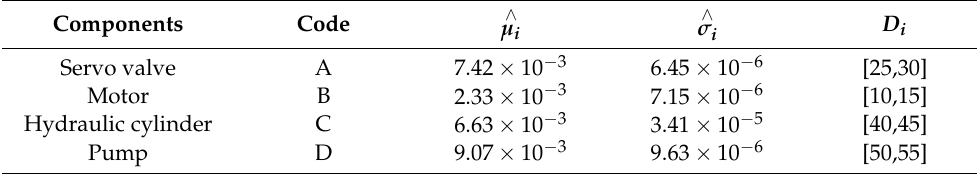
Table 1. IG distribution parameter values of several components.